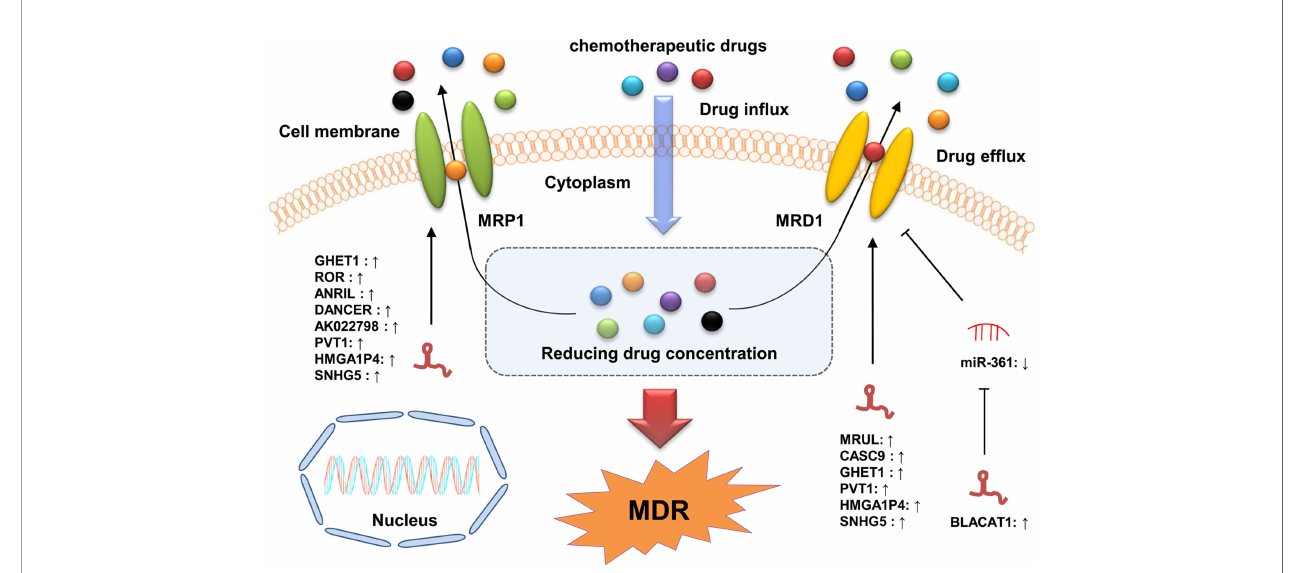
FIGURE 3 | LncRNAs participate in GC drug resistance by regulating MDR-related genes. The ABC transporters export chemotherapeutic drugs out of GC cells, resulting in chemotherapy resistance with decreased concentrations of the drugs intracellularly. LncRNAs can modulate MDR by increasing the expression of MDR- related genes ( MDR1 and MRP1 ) via directly binding to speci fi c miRNAs or